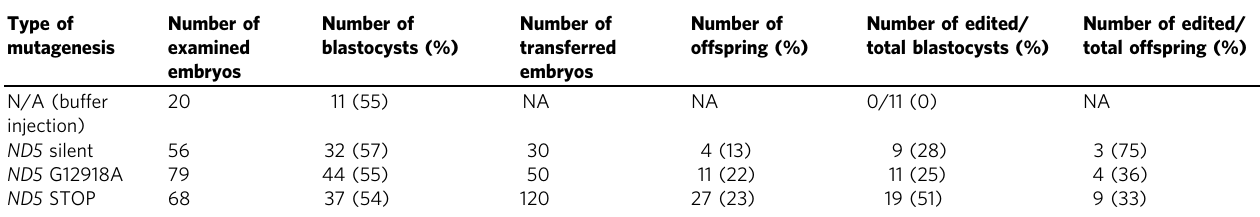
Table 1 Summary of the numbers of blastocysts used and mutants